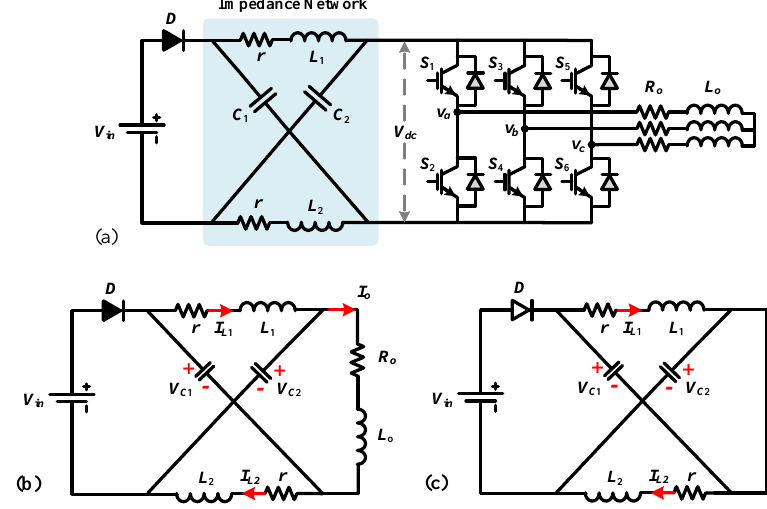
Figure 1. Schematic of a three-phase voltage-fed Impedance Source Inverter (ZSI) in ( a ) general mode, ( b ) non-shoot-through mode, and ( c ) shoot-through